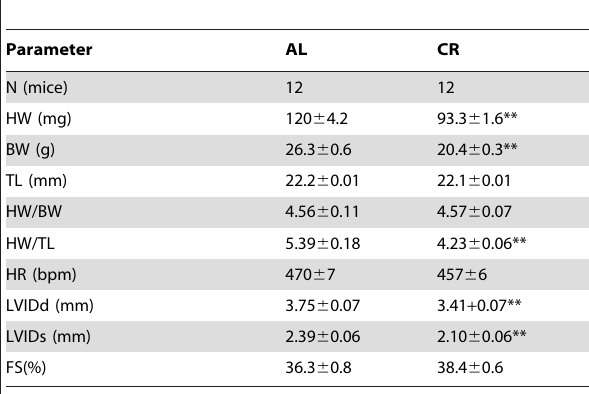
Table 2. Cardiac gravimetric and echocardiographic